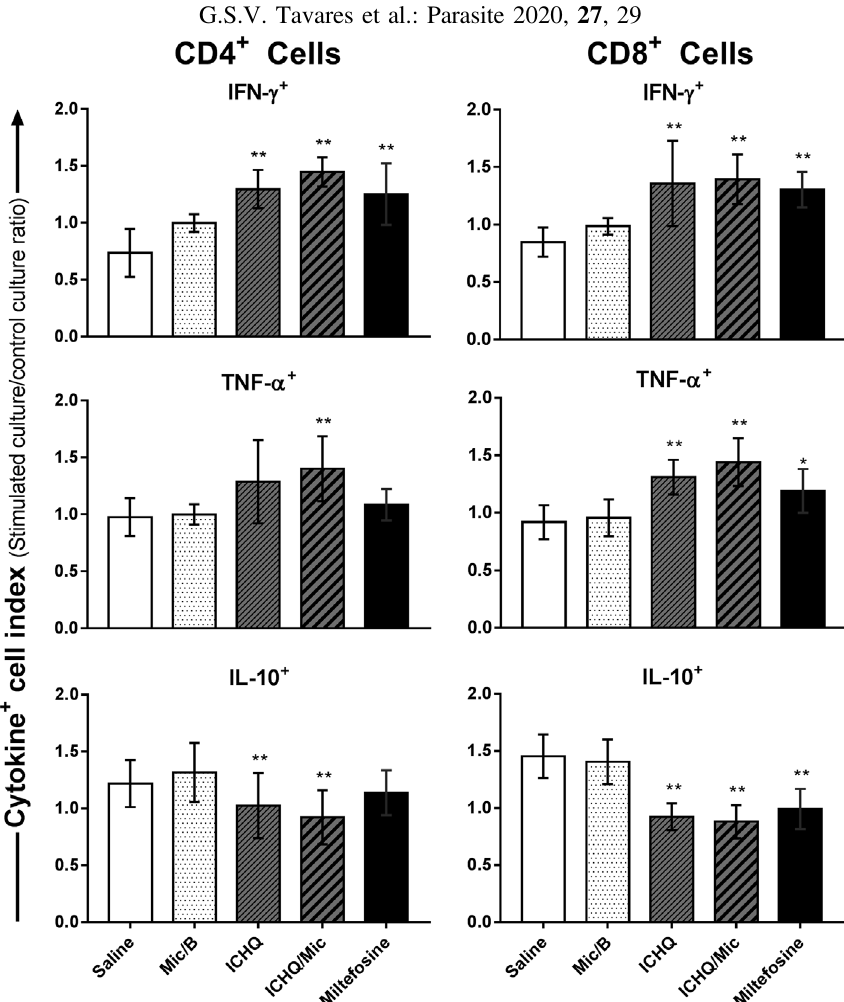
Figure 4. Intracytoplasmic cytokine-producing CD4 + and CD8 + T-cell frequency in the treated and infected animals. BALB/c mice were infected with Leishmania infantum promastigotes and received saline or were treated with empty micelle (B/Mic), miltefosine, ICHQ, or ICHQ/Mic. The animals were euthanized 15 days after treatment, when their splenocytes were collected and non-stimulated or in vitro stimulated with SLA (50 l g/mL) for 48 h at 37 (cid:5) C in 5% CO 2 . Results were expressed as cytokine indexes (stimulated culture/control culture ratio) to obtain the IFN- c , TNF- a and IL-10-producing CD4 + and CD8 + T cell frequency. Bars indicate the mean ± standard deviation of the groups. (*) and (**) indicate statistically signi fi cant differences in relation to the saline and B/Mic groups, respectively ( p <